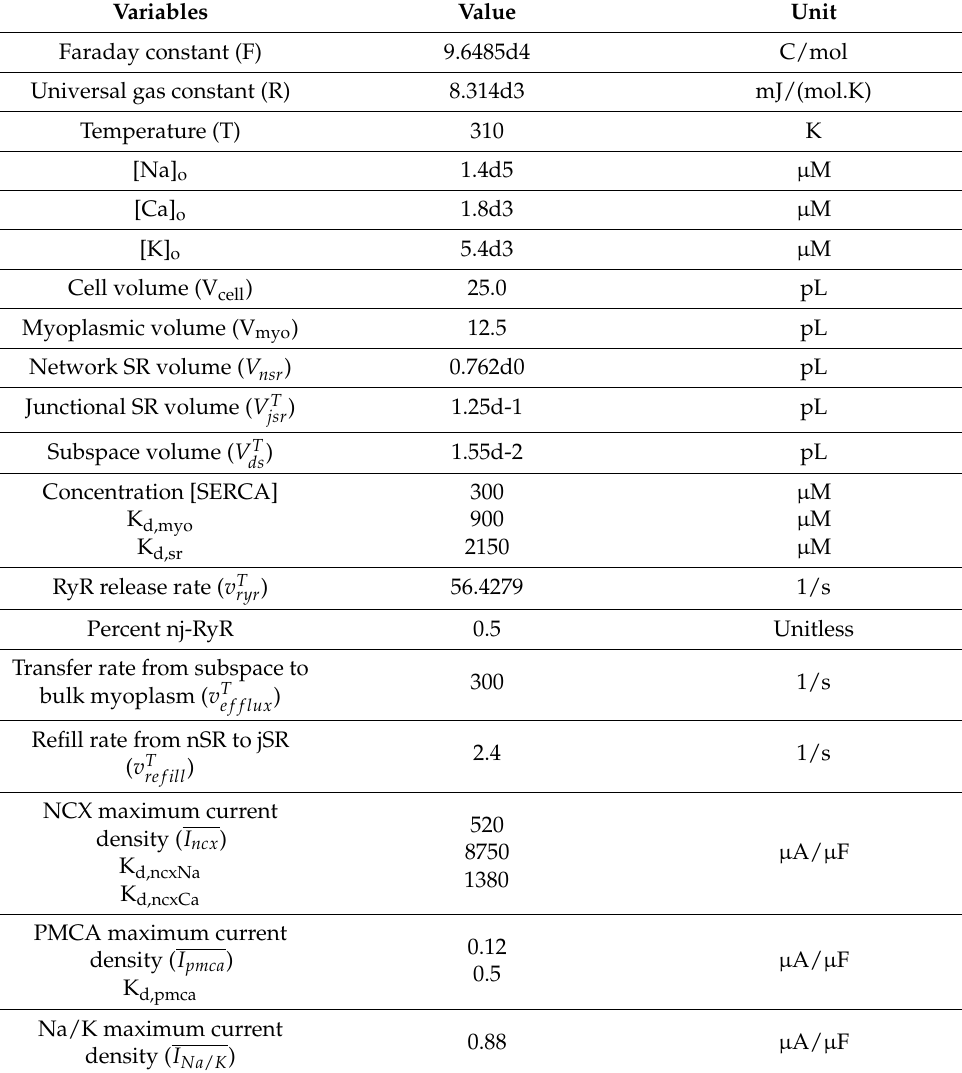
Table A3. Constant data and whole-cell level data.